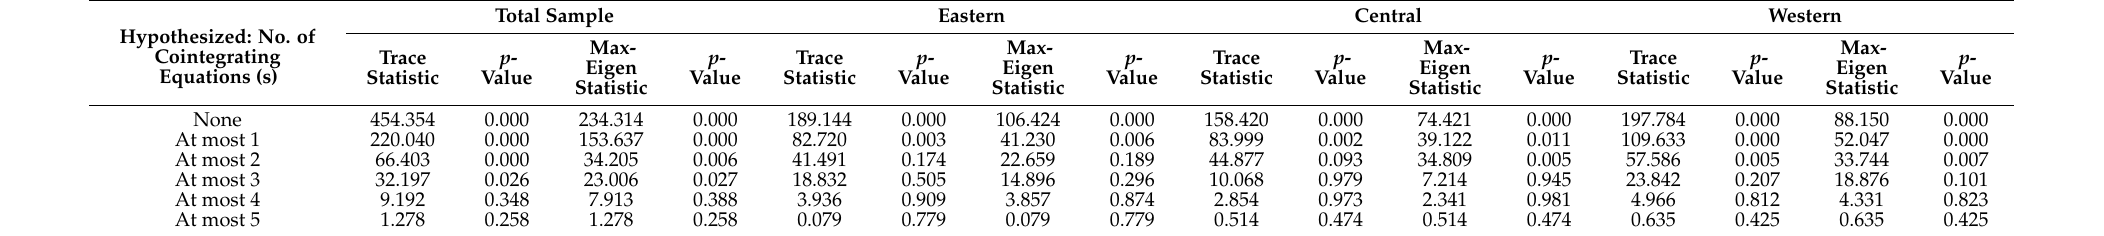
Table 3. Results of Johansen cointegration